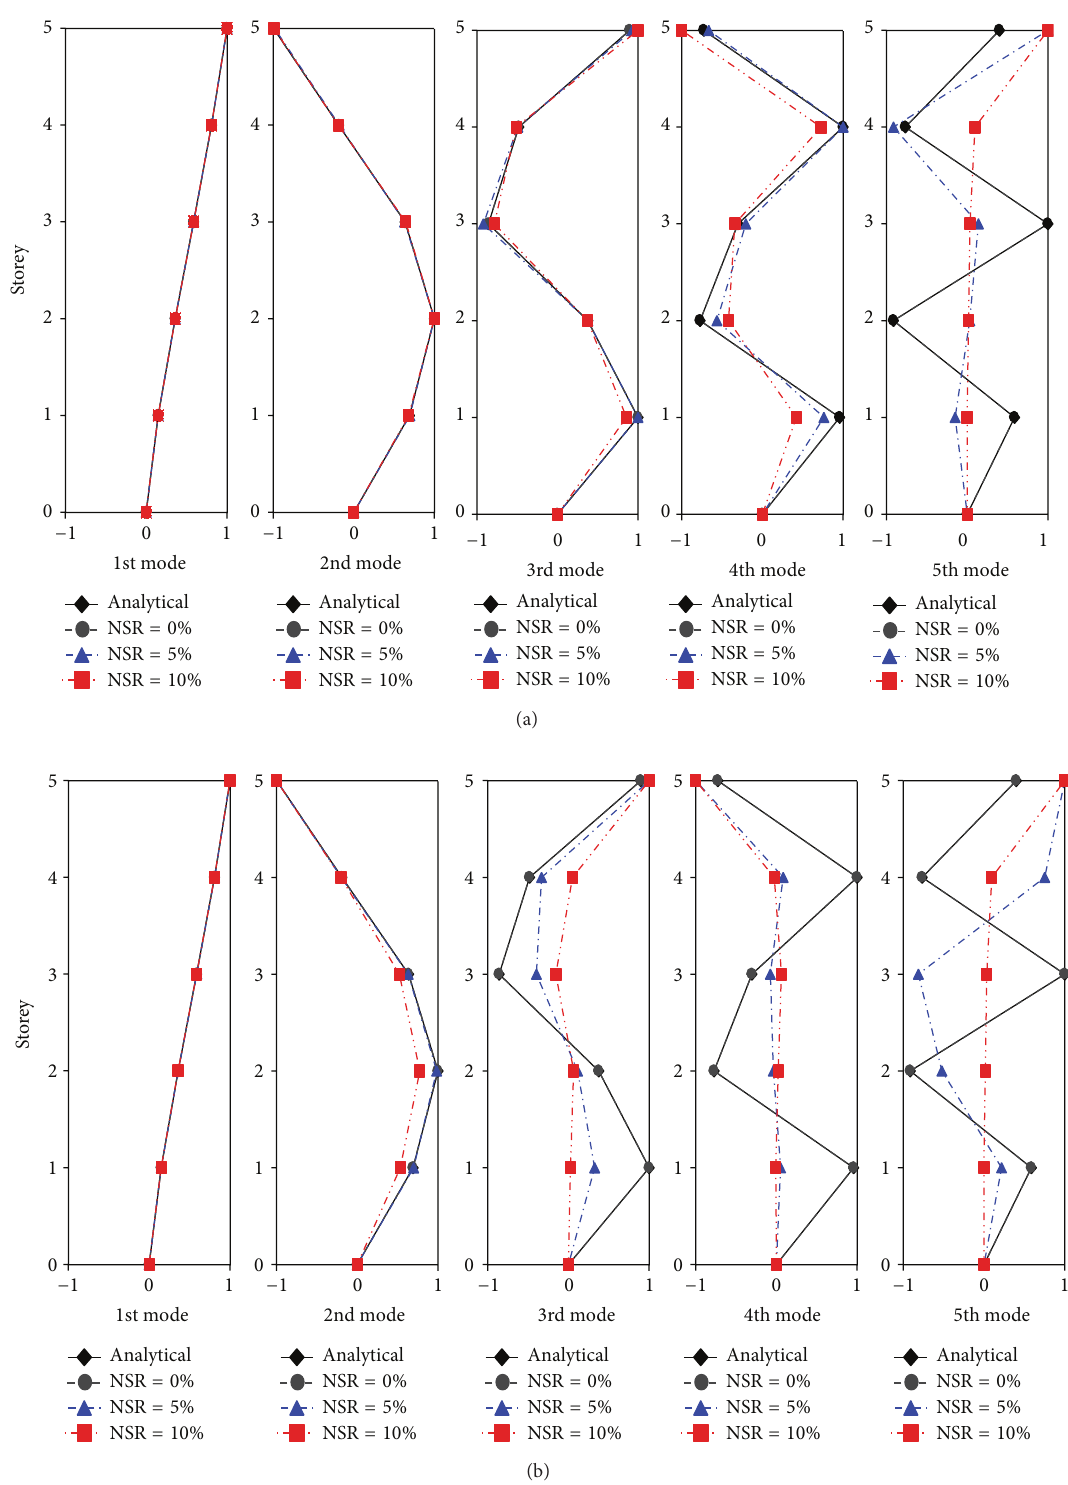
Figure 2: (a) Mode shapes identified with N4SID under various noise levels. (b) Mode shapes identified with SRIM under various noise